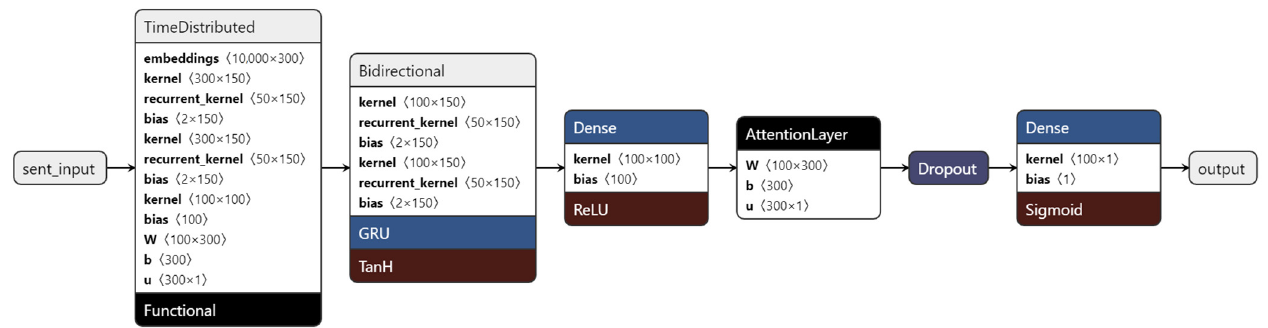
Figure 3. Implemented GRU ‐ NN.